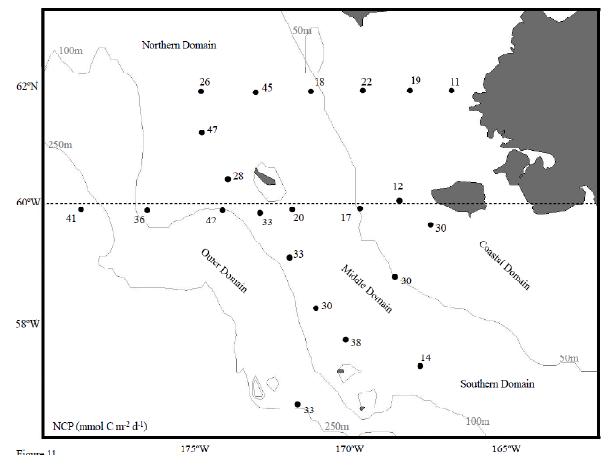
Fig. 11. Net Community Production based on the seasonal con- sumption of normalized DIC and corrected for the production of calcium carbonate minerals inmmolesCm − 2 d − 1 across the shelf. Values were highest along the central front and lowest along the